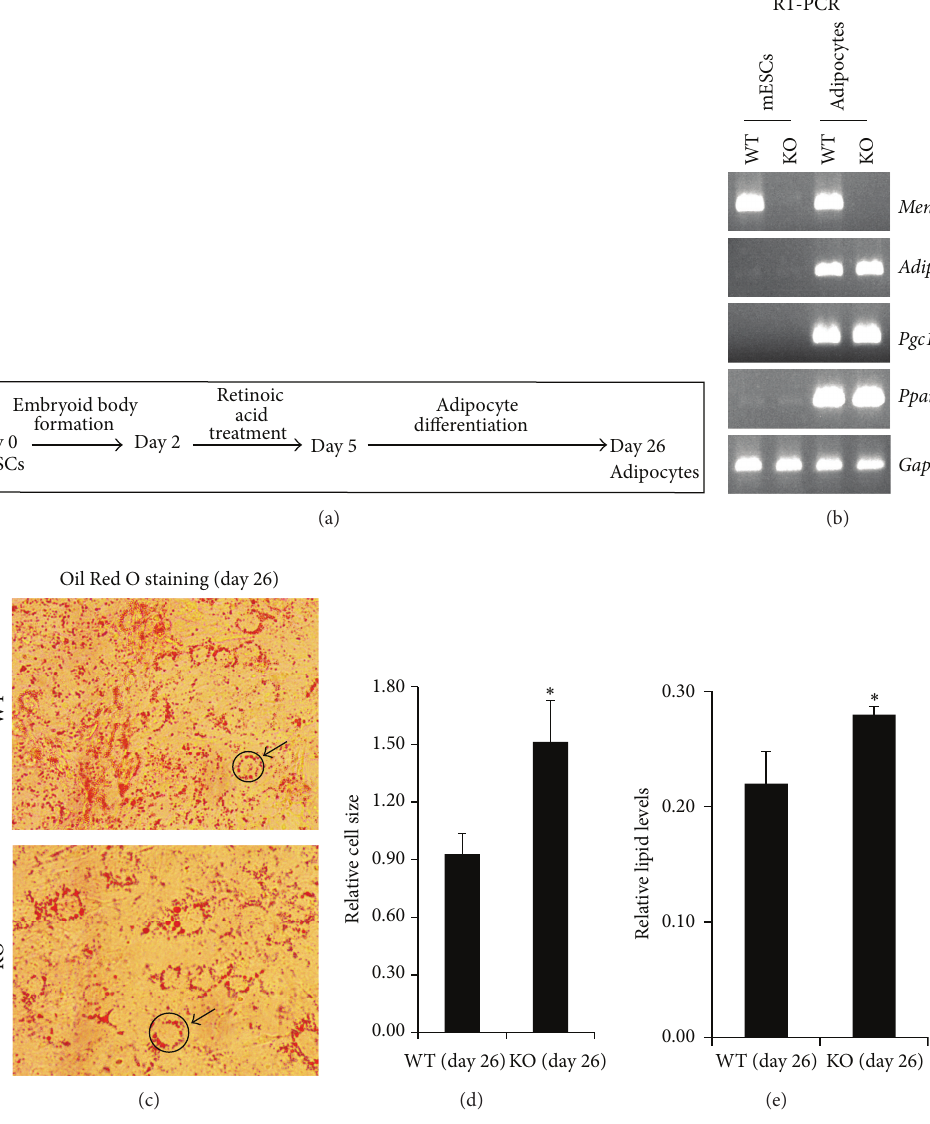
Figure 1: Menin-null (Men1-KO) mouse embryonic stem cells (mESCs) can undergo in vitro differentiation into adipocytes and show increased adipocyte cell size. (a) In vitro adipogenesis. Feeder-free mESCs (WT or Men1-KO) were allowed to form embryoid bodies (EBs) in medium without LIF for 2 days, followed by retinoic acid treatment for 3 days. On day 5, retinoic acid induced EBs were cultured in gelatin-coated plates with adipocyte differentiation medium for 21 days to obtain adipocytes, and the medium was replaced every 2 days. (b) Expression of adipocyte marker genes. Conventional RT-PCR followed by agarose gel electrophoresis of the adipocyte marker genes ( Adiponectin , Pgc1 𝛼 , and Ppar 𝛾 ), Men1 , and an internal control gene ( Gapdh ) using RNA samples before and after in vitro differentiation of WT or Men1-KO (KO) mESCs into adipocytes. (c) Oil Red O staining. Bright-field microscopy images of WT and Men1-KO mESCs stained for lipids/triglycerides after adipogenesis by Oil Red O staining show round adipocyte cells with lipid droplets (orange colored spots). Magnification = 400x. (d) Relative cell size. After adipogenesis, Oil Red O staining for lipids/triglycerides was performed, and images were captured by bright-field microscopy shown in (c). Cell diameter was measured as an index of cell size from 3 to 5 microscopy fields using the outline formed by the circle of orange lipid droplets accumulated inside the round adipocytes (an example marked with a black circle and arrow is shown in (c)). Diameter mean and SD are shown ( ∗ 𝑝 < 0.05 ). Note: the units on the 𝑦 -axis do not reflect the actual diameter of the cells but they reflect the measurement of the cell diameter from images captured at 400x magnification. (e) Relative lipid content. After adipogenesis, Oil Red O staining for lipids/triglycerides was performed, dye was extracted, and the OD was measured at 520 nm. Relative lipid level (OD at 520 nm) is shown for adipocytes. Error bar = SD. ∗ 𝑝 < 0.05